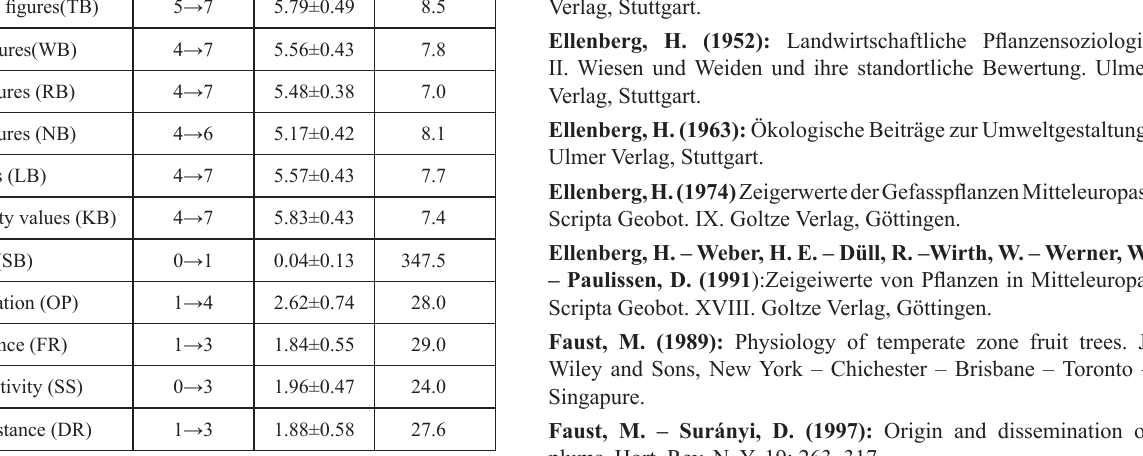
Table 2. Relative ecological indicator values of plum cultivars Relative ecological